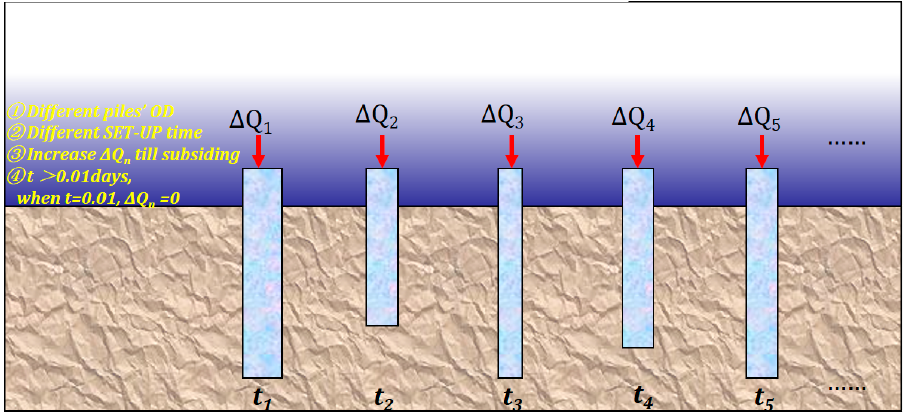
Figure 4. Schematic of soil strength recovery factor test method.